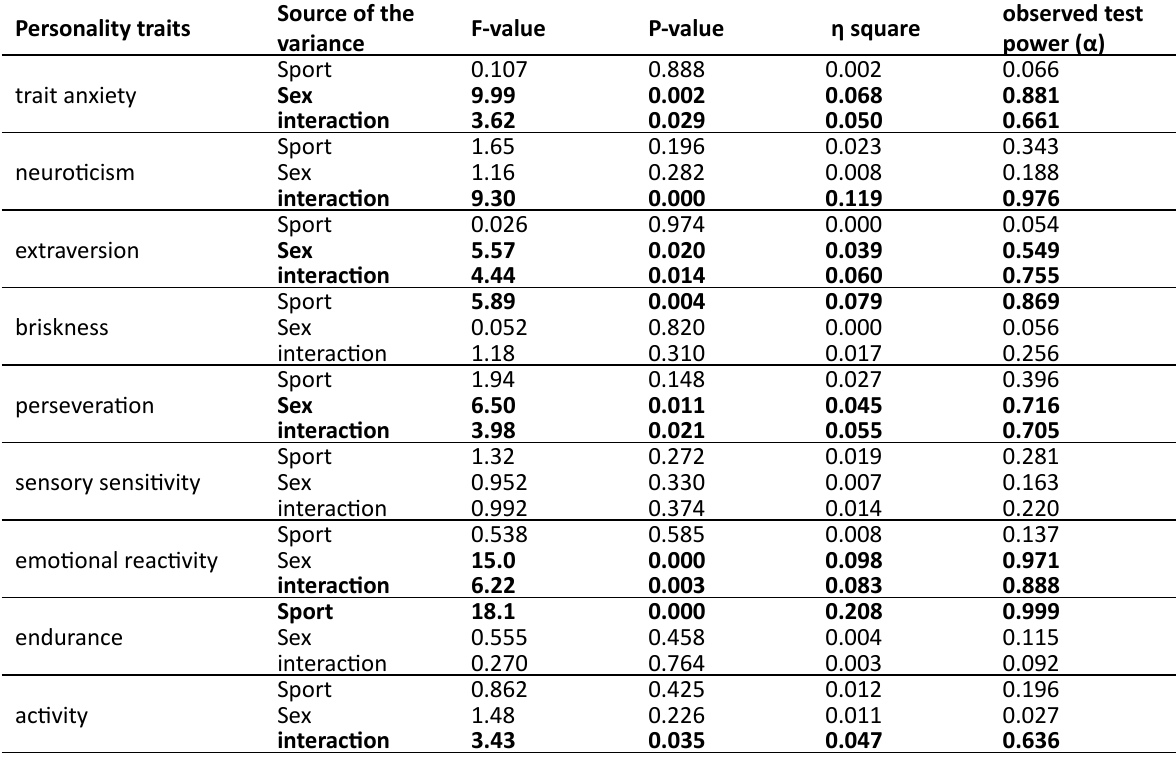
Table 3. Detailed results of variance analysis for selected personality traits Personality traits